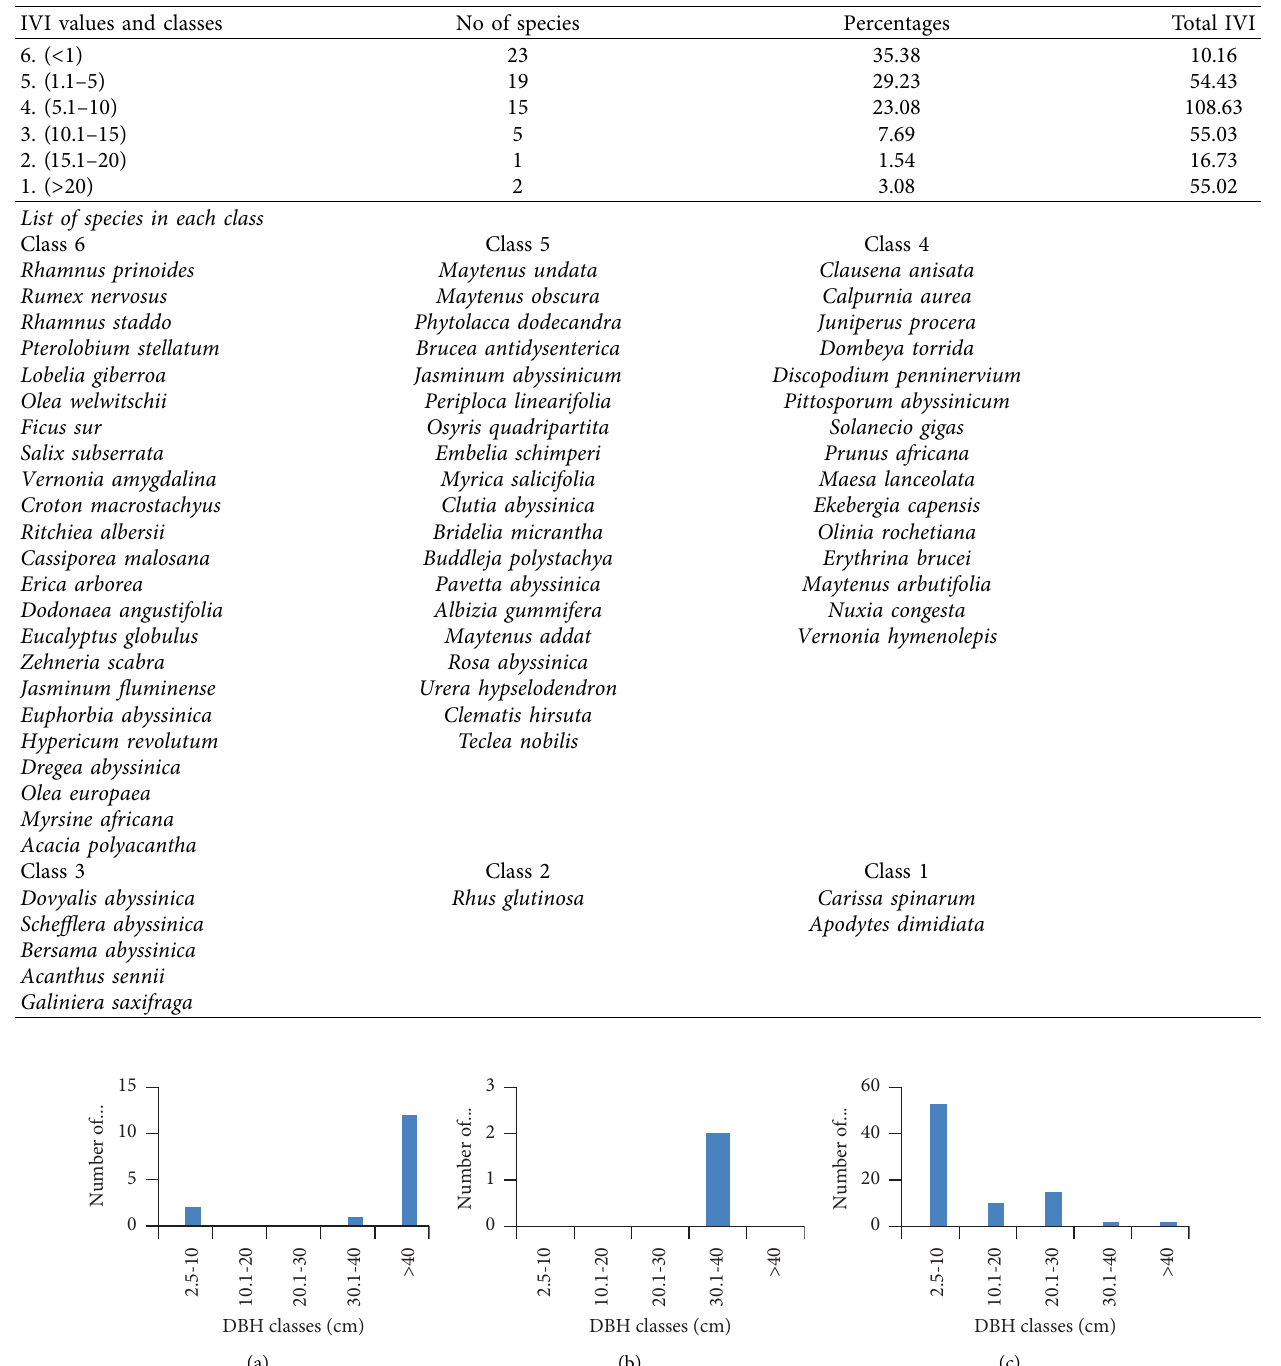
Table 8: IVI classes and number of species in each class in Jib Godo Natural Forest.